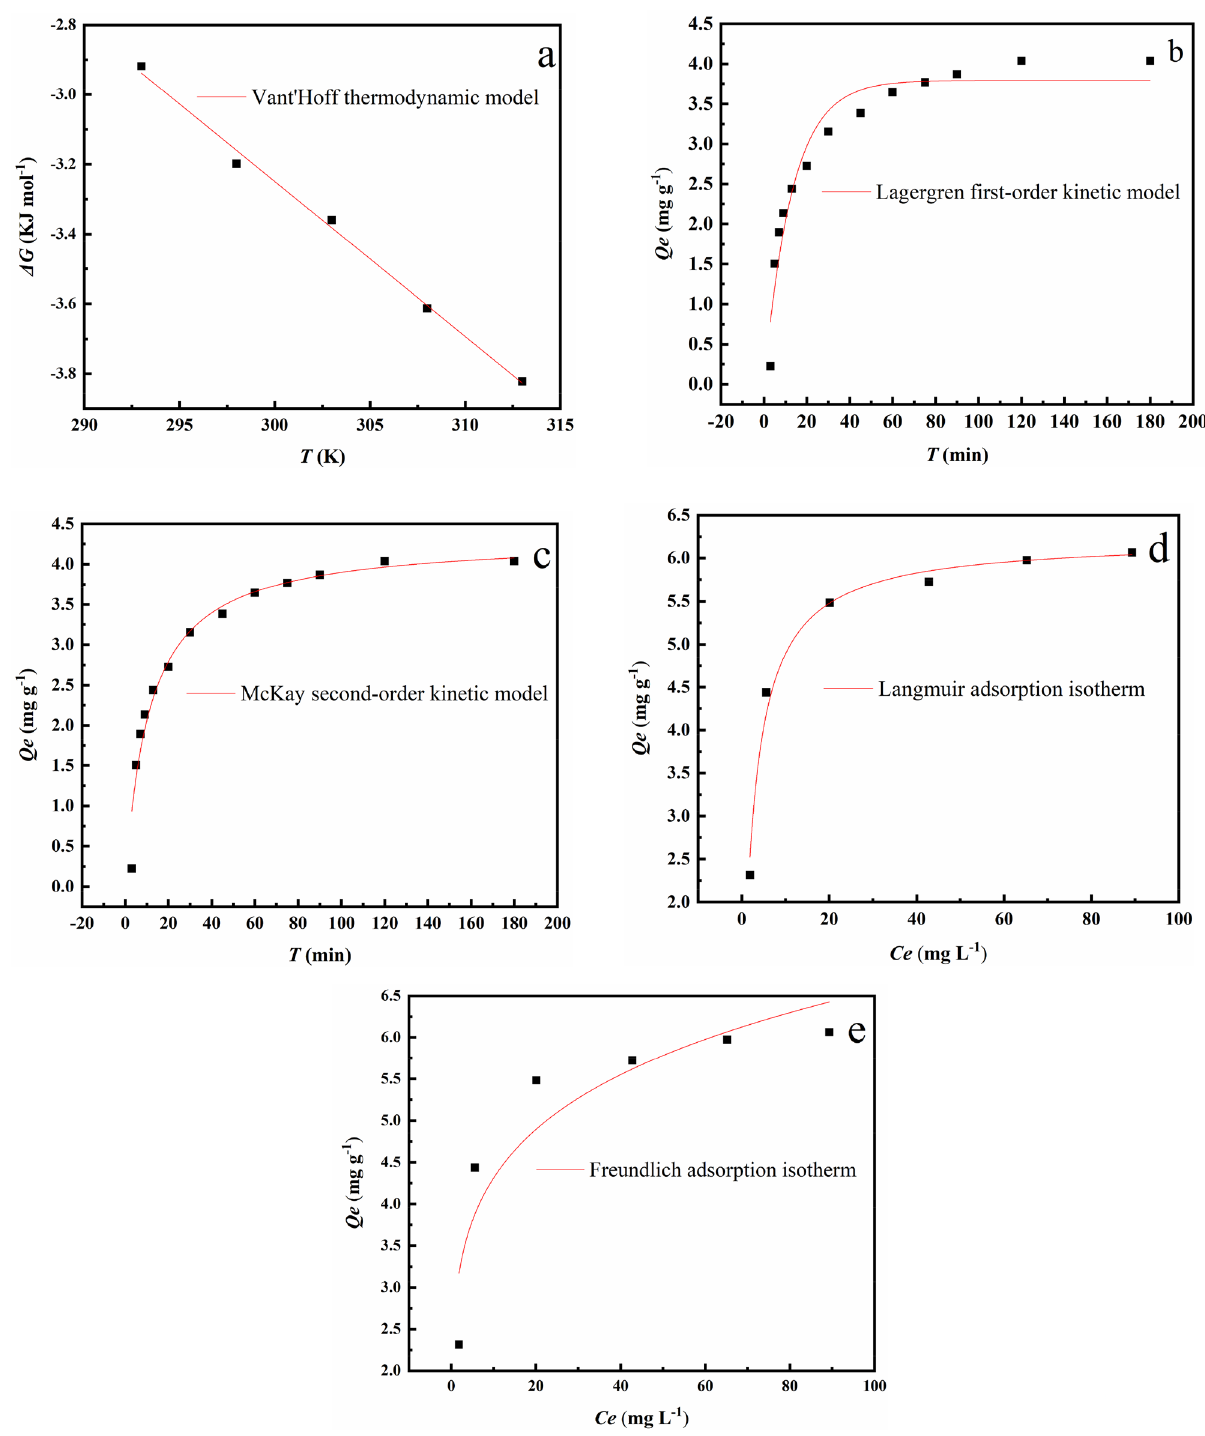
Figure 12. Fitting plots of ( a ) Vant’Hoff thermodynamic, ( b ) Lagergren kinetic, ( c ) McKay kinetic, ( d ) Langmuir adsorption isotherm,and ( e ) Freundlich adsorption isotherm